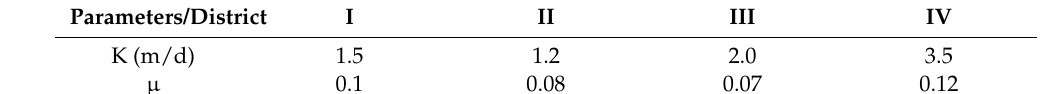
Table 2. Hydrogeological parameters.